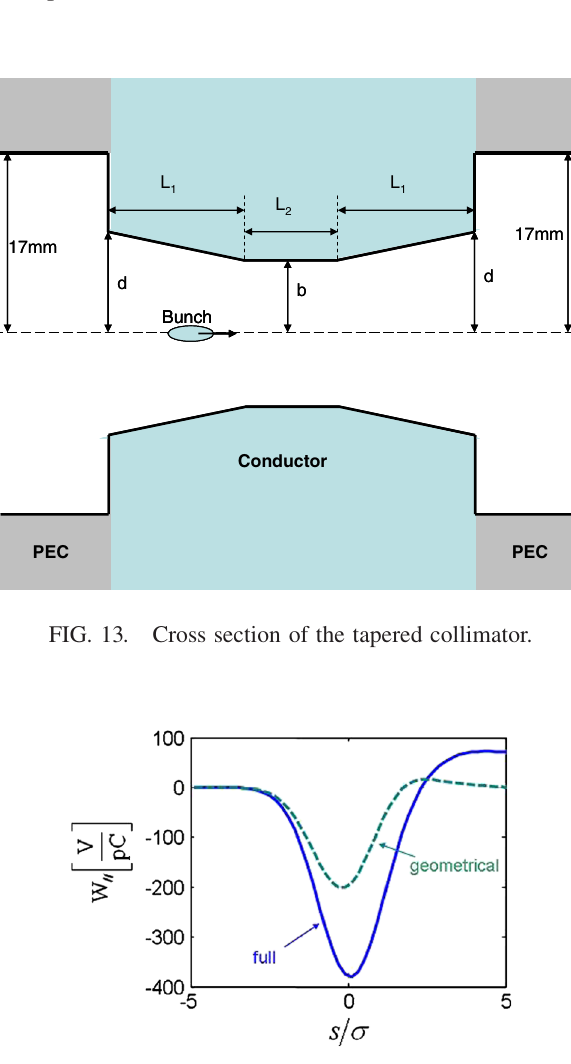
FIG. 14. Longitudinal wake potentials for the tapered collima- tor with finite (blue solid) and perfect (green dashed) conducting